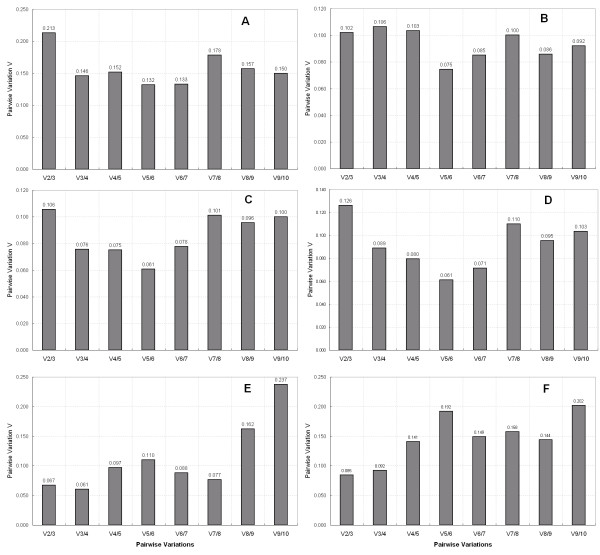
Determination of the optimal number of reference genes. Pairwise variation calculated by geNorm to determine the minimum number of reference genes for accurate normalization in all the samples (A), fruit developmental series (B), different genotypes (C), different storage time series (D), different exogenous regulator treatments (E), different tissues (F). Every bar represents change in normalization accuracy when stepwise adding more endogenous reference genes according to the ranking in Figure 2.